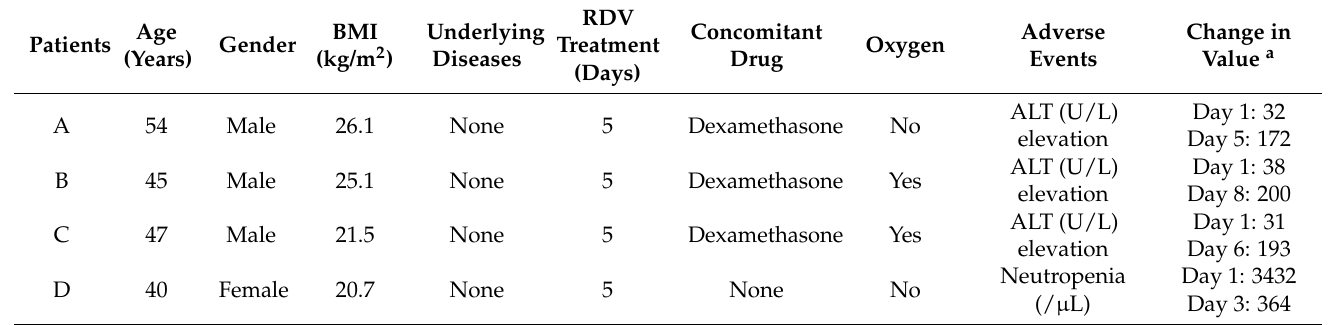
Table 3. Clinical characteristics and CTCAE Grade 3 adverse effects in COVID-19 patients on RDV